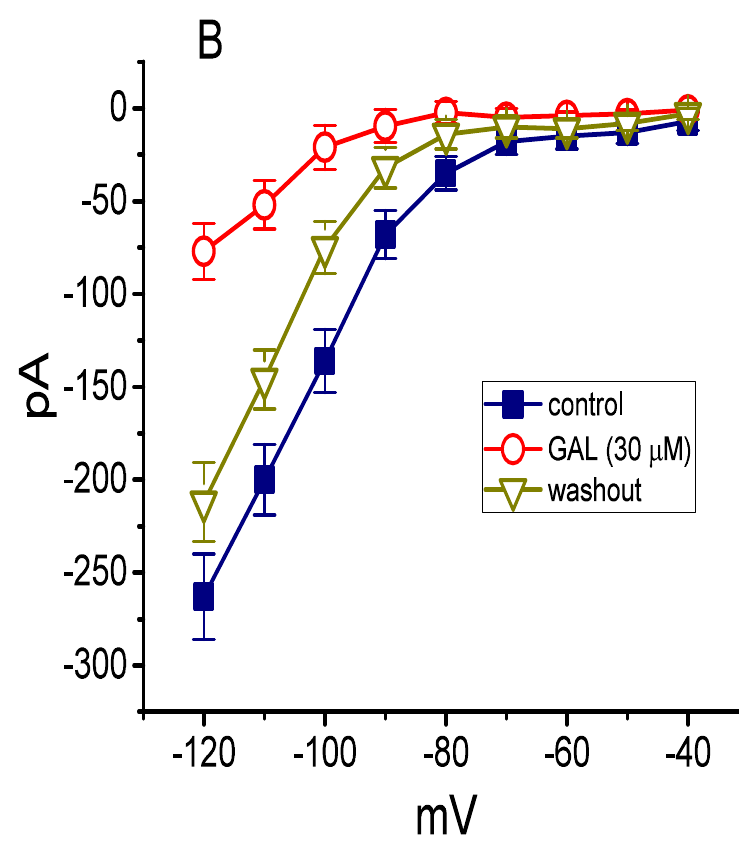
Figure 9. Inhibitory effect of GAL-021 on hyperpolarization-activated cationic current ( I h ) identified in GH 3 cells. In these whole-cell current recordings, cells were bathed in Ca 2+ -free, Tyrode’s solution, and the recording pipette was filled with K + -containing solution. (A) Representative I h traces obtained in the absence (upper) or presence (lower) of 30 μ M GAL-021. The uppermost part indicates the voltage-clamp protocol applied. (B) Averaged I-V relationships of I h amplitude obtained in the control (i.e., in the absence of GAL-021), during the exposure to 30 μ M GAL-021 and washout of GAL-021 (mean ± SEM and n = 8 for each data point). Current amplitude was collected at the end of 2 sec hyperpolarizing potential.